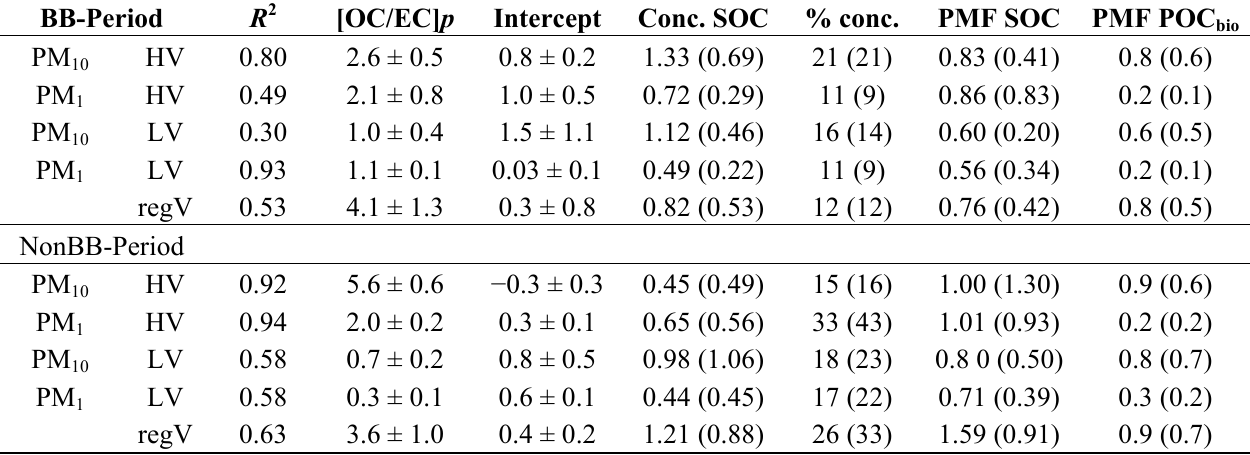
Table 3. Estimated parameters of the linear fit and mean (median) SOC-